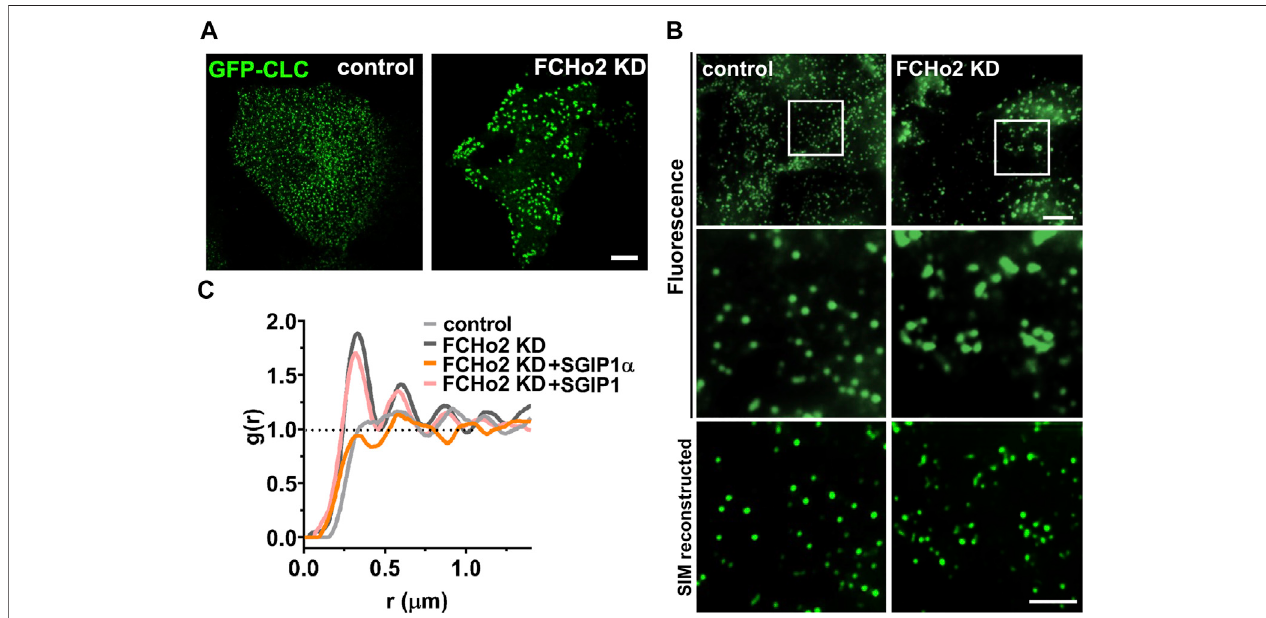
FIGURE 3 | SGIP1 α , not SGIP1, can reverse the altered clathrin patterning in FCHo2 KD cells. (A) Representative fl uorescence images of EGFP-tagged clathrin light chain (CLC) in HeLa cells. HeLa cells were transfected with either control or siRNA FCHo2 and EGFP-tagged CLC. Scale bar: 10 μ m. (B) Representative SIM reconstructed images of clathrin in control and FCHo2 KD HeLa cells. Scale bars: 5 and 2 μ m, respectively. (C) The pair correlation function g(r) plot of control, FCHo2 KD, FCHo2 KD + SGIP1 α , and FCHo2 KD + SGIP1.